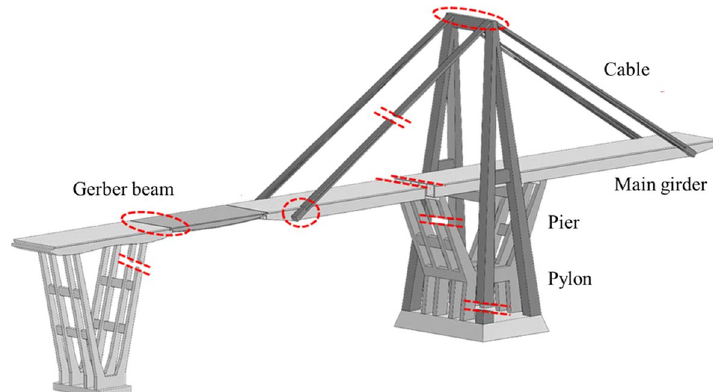
Fig. 12 The basic structure of the Morandi Bridge